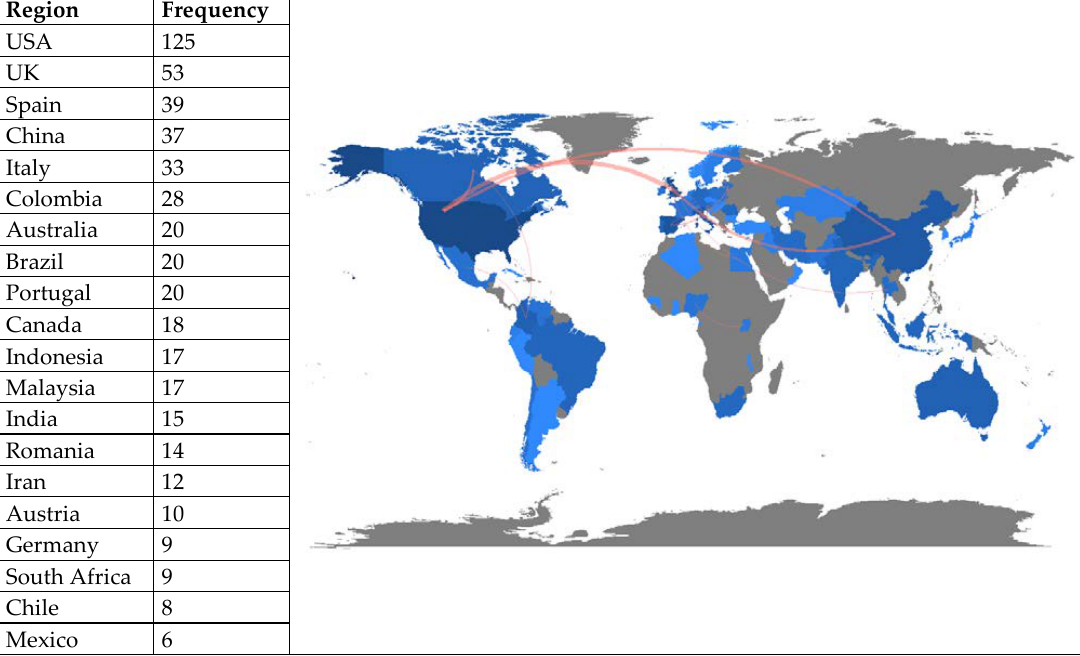
Figure 15. Frequency of appearance of countries and collaboration.